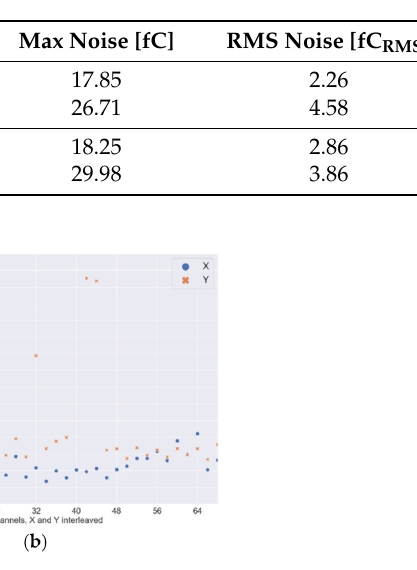
Table 2. Noise characteristic of the detector with ceramic readout boards.